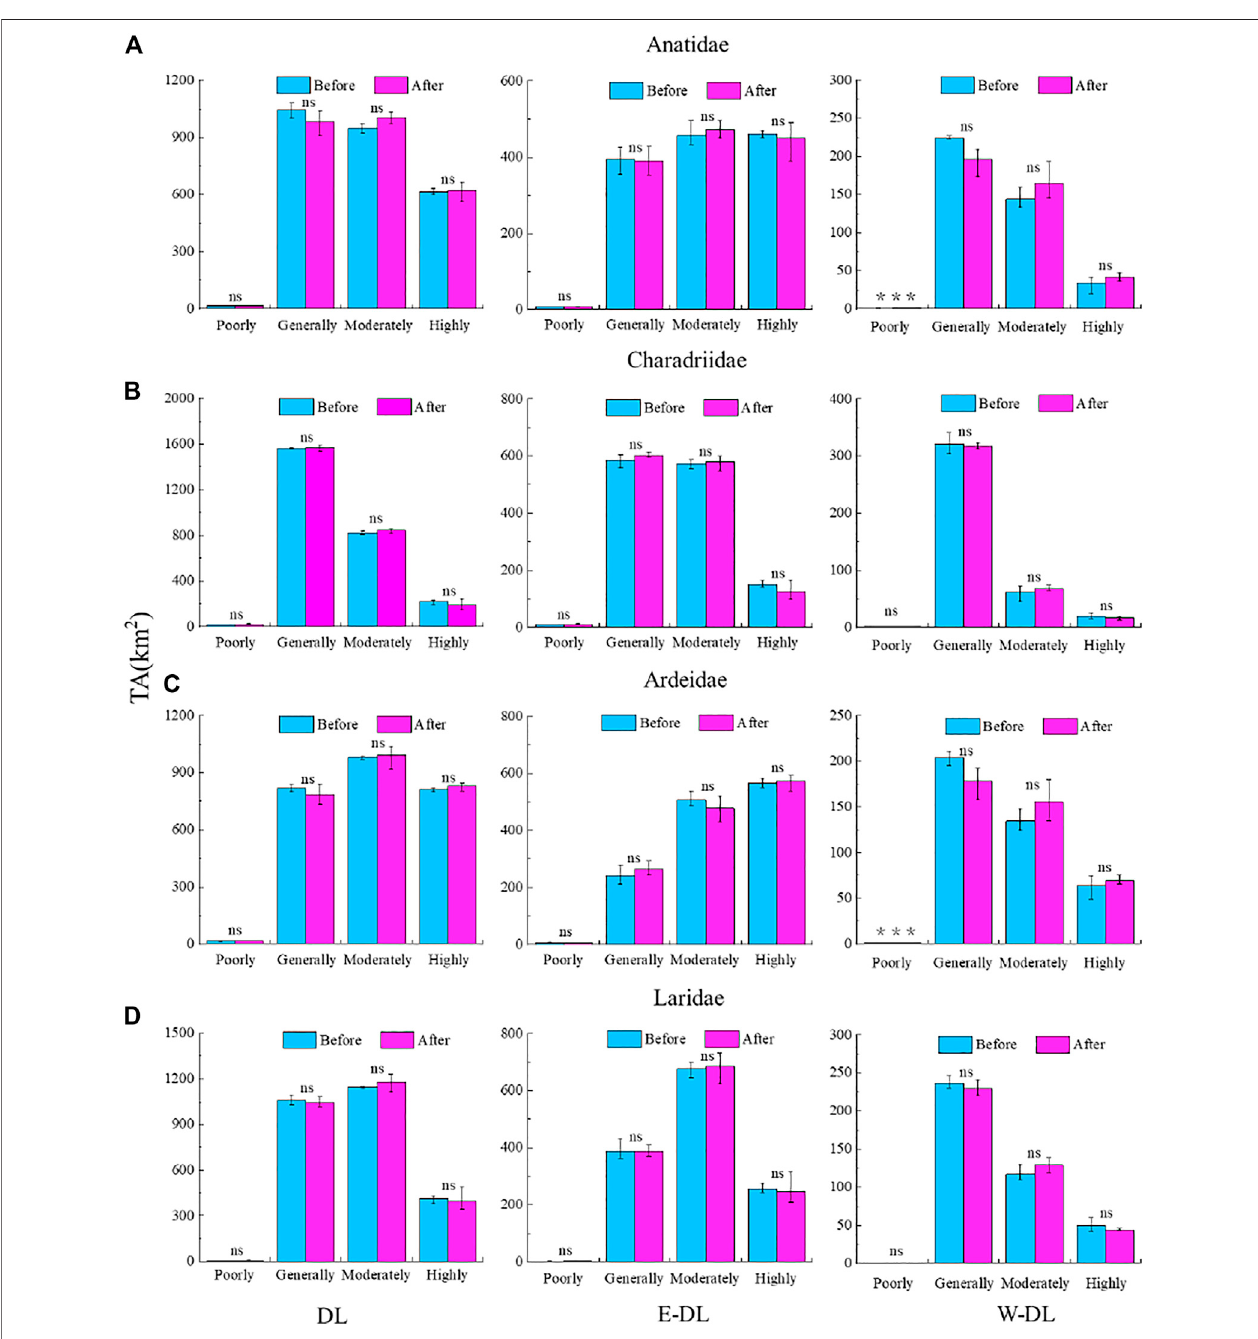
FIGURE4| TheTA(totalarea)ofeachgradeofhabitatsuitabilityfor (A) Anatidae, (B) Charadriidae, (C) Ardeidaeand (D) LaridaeofbeforePERandafterPERinDL, E-DLandW-DLrespectively.Errorbarsaroundthemeanrepresentthemaximumandminimumvaluesofthisgroupofdatarespectively.TheinformationofTAinHLand S-DL are showing in Supplementary Figure S6